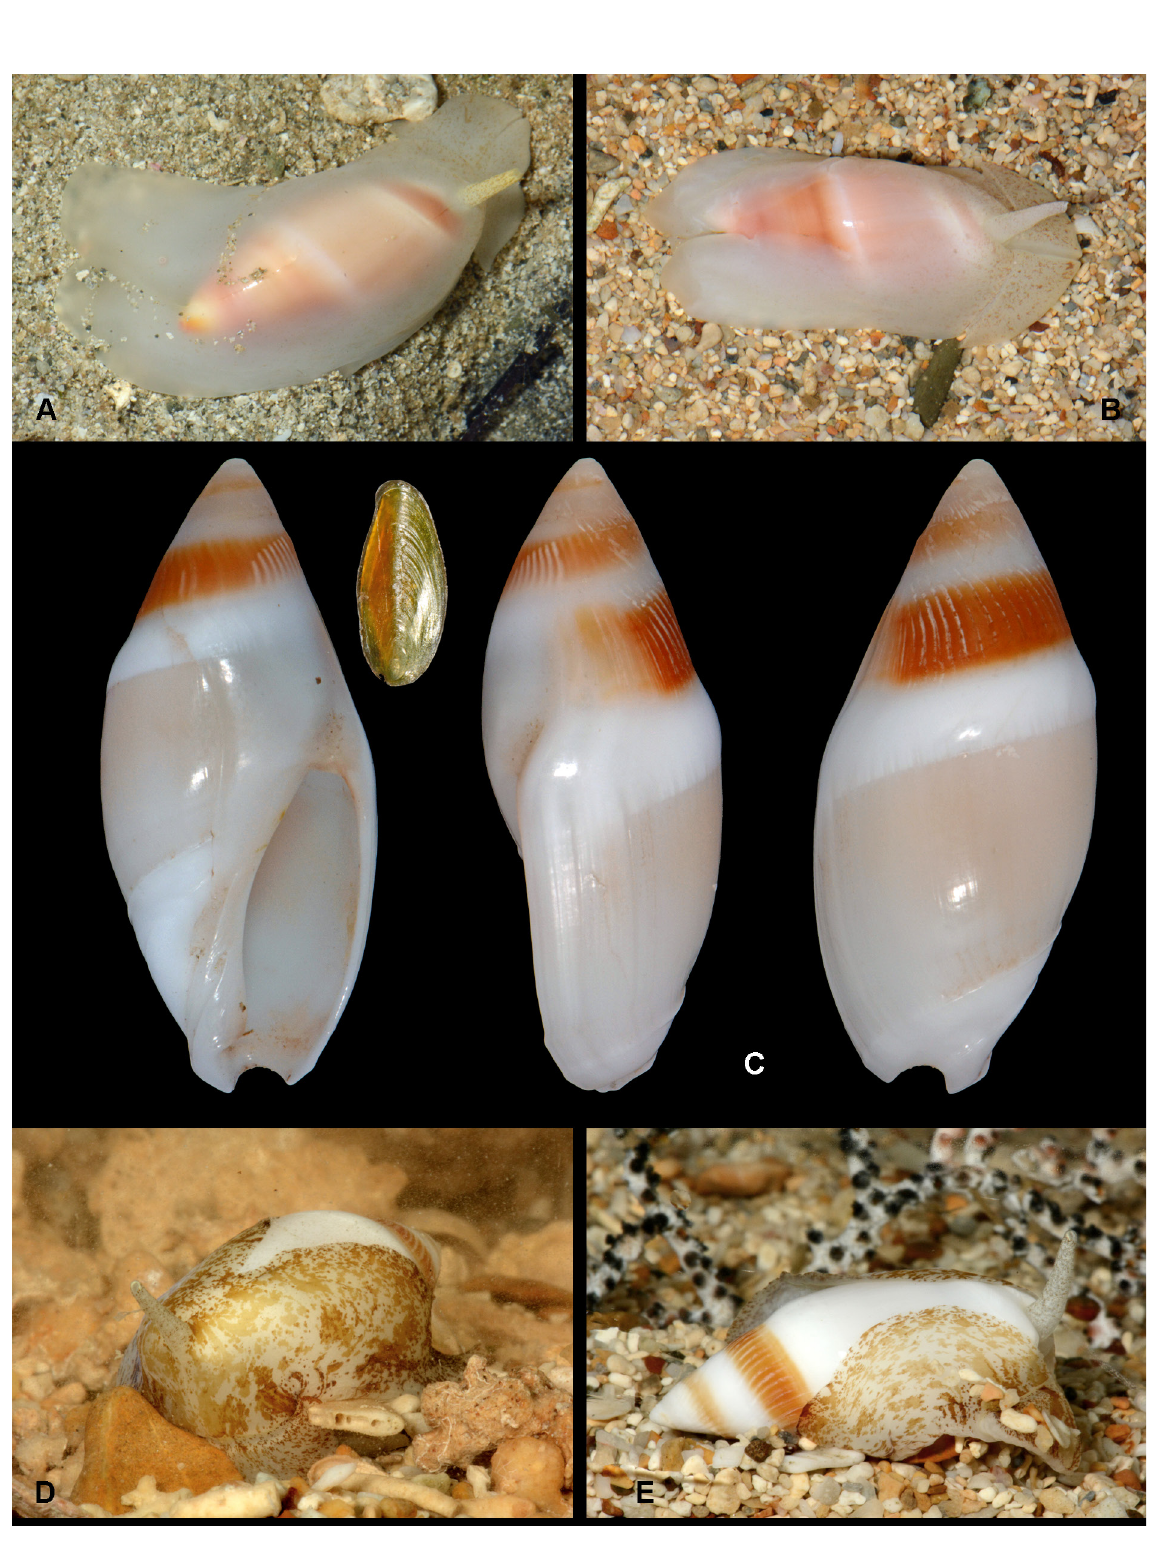
Fig. 14. A–B . Live specimens of Amalda montrouzieri (Souverbie, 1860), Nouméa, 8 m. C–E . S hell and live specimen of A. herberti Cossignani, 2013, Nouméa, South Lagoon, about 250 m. Photos courtesy of